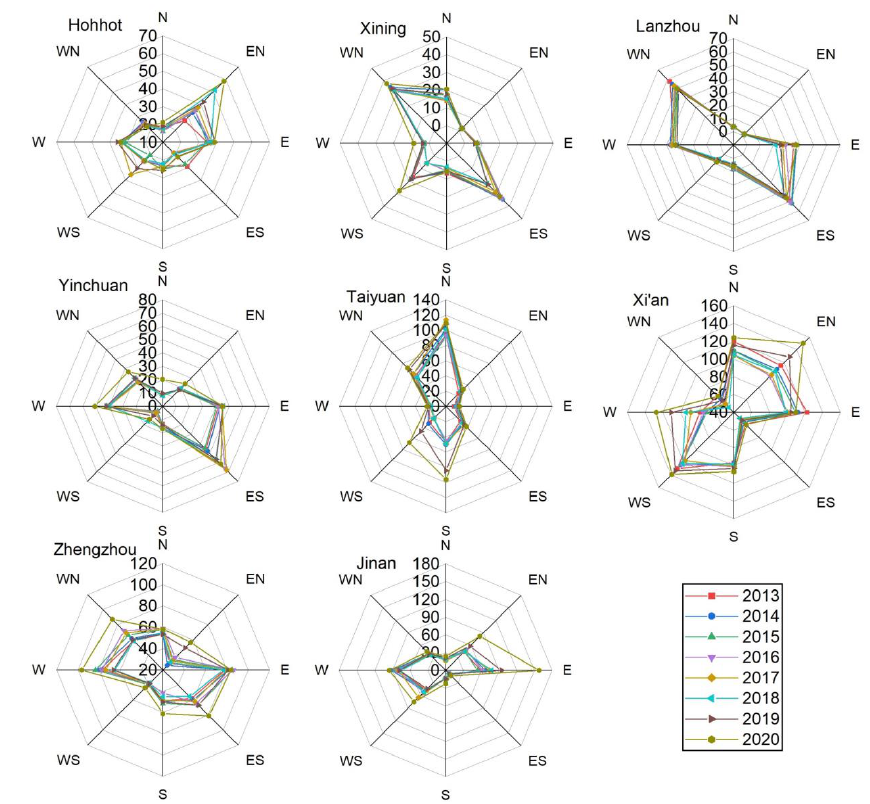
Figure 5. Spatial differentiation of urban built-up area expansion in the Yellow River Basin from 2013 to 2020.